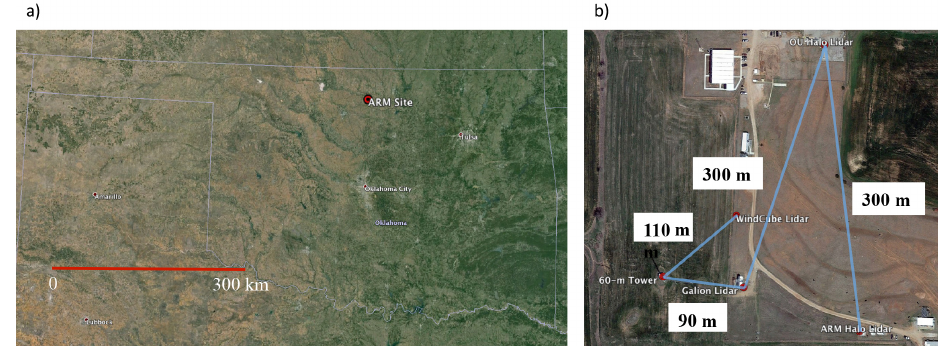
Figure 2. (a) Google Earth image of the state of Oklahoma. Location of Southern Great Plains ARM site is denoted by red marker. (b) Google Earth image of the central facility of the Southern Great Plains ARM site. Instrument locations are denoted by red markers. Approximate distances between instruments are indicated by blue lines and